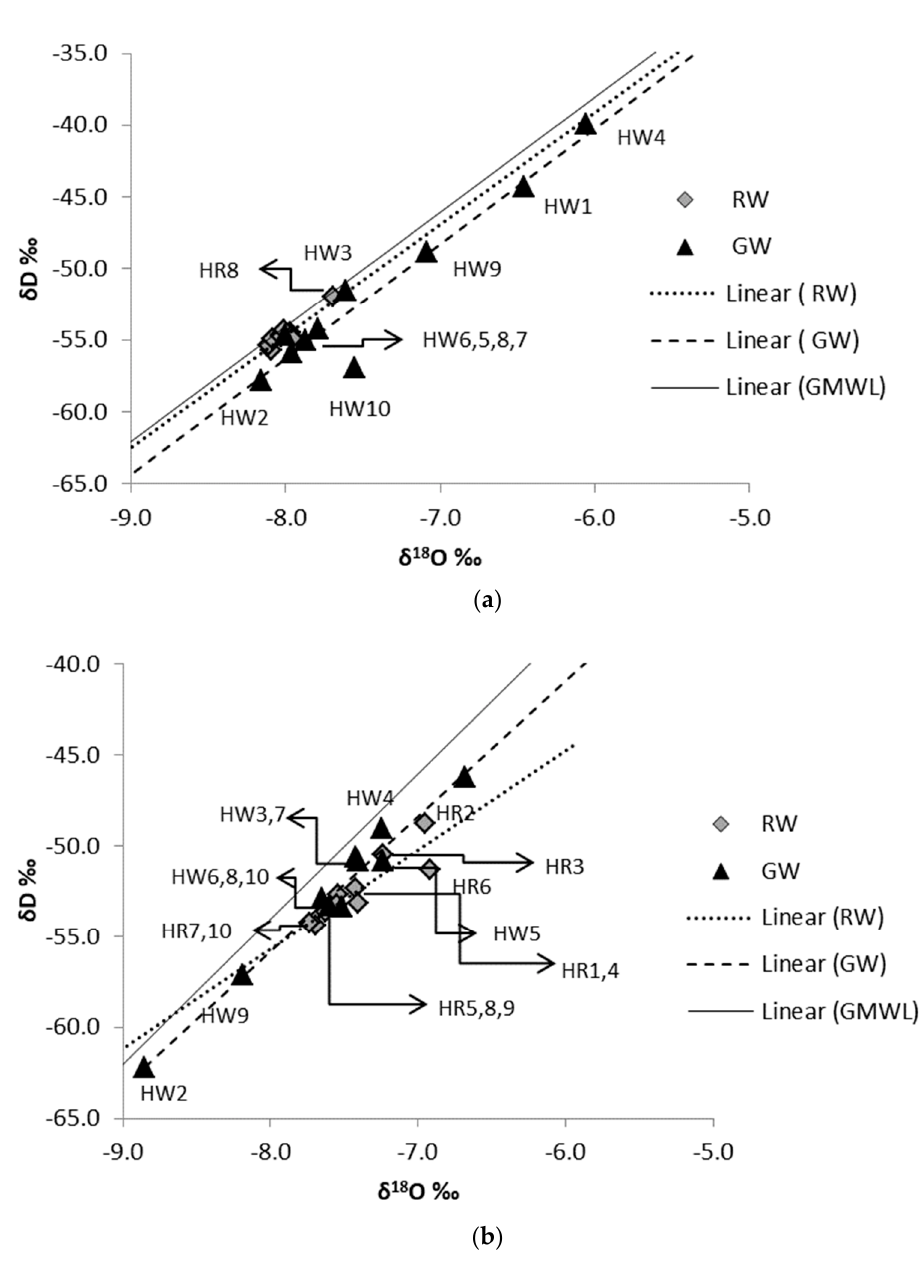
Figure 4. δ D verses δ 18 O plots of groundwater and river water in ( a ) wet season and ( b ) dry season. HW = Hanumante groundwater, HR = Hanumante river water. GMWL represents global meteoric water line [45]; linear (RW) = trend line of river water; linear (GW) = trend line of groundwater.